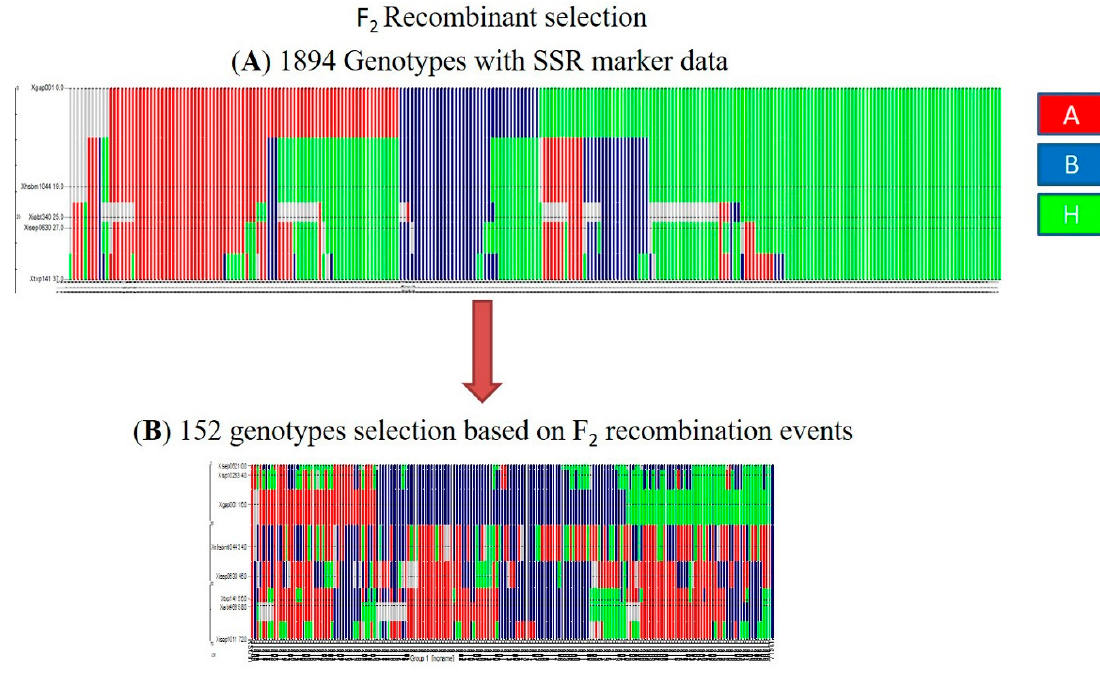
Figure 1. ( A ) F2 1894 fine-mapping population screened with 5 SSR markers within the QTL flanking region of SBI-10L, showing homozygous, heterozygous, and recombinant alleles. Allele ‘A’, homozygous for parent RSG04008-6, ‘B’ homozygous allele for parent J2614-11, and ‘H’ is a heterozygous allele from both parents. ( B ) Selected 152 recombinants based on the SSR markers data.